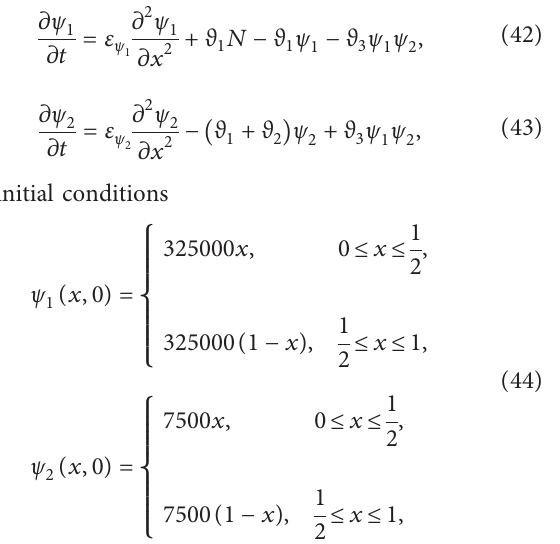
Figure 5: Mesh graphs and plot graphs of ψ � 1 , ϑ � 3 . 4 , λ � λ � 0 . 0006 , and ε κ � 0 . 1 , ϑ 1 2 1 2 graph of ψ 2